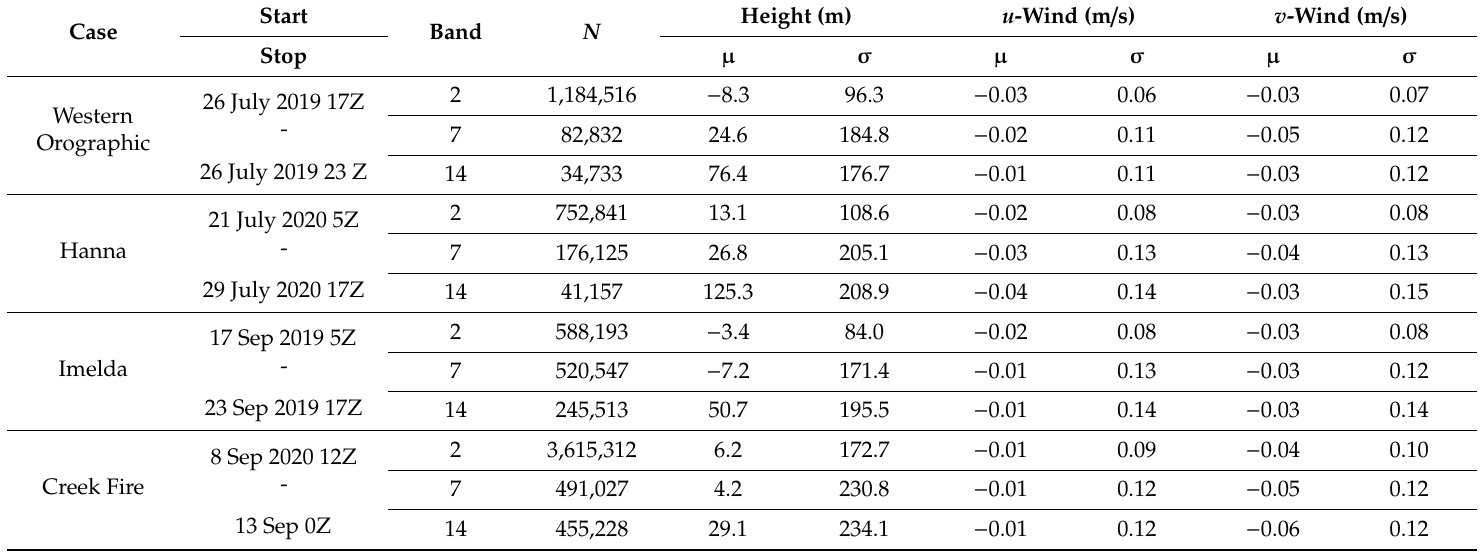
Table 2. Ground-point mean ( µ ) and standard deviation ( σ ) statistics are presented for cases run on the NASA Discover supercomputer indicate the uncertainties in stereo-winds